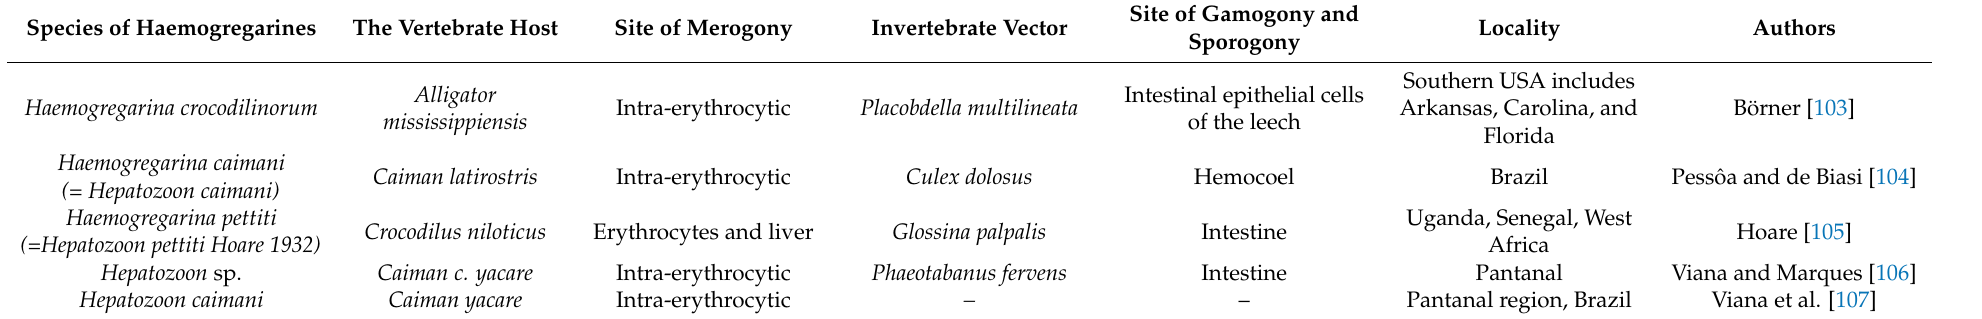
Table 7. Haemogregarines of crocodilians.